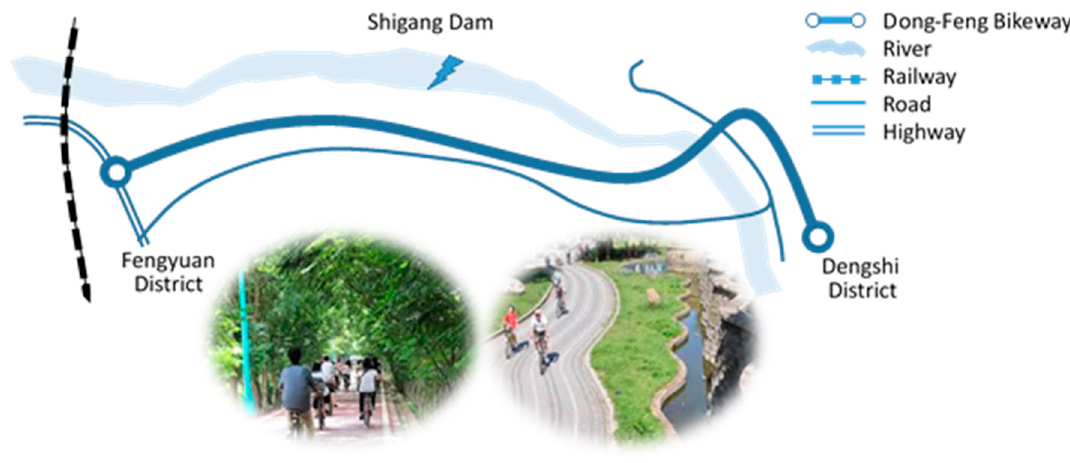
Figure 1. Dong-Feng Cycleway map and pictures.